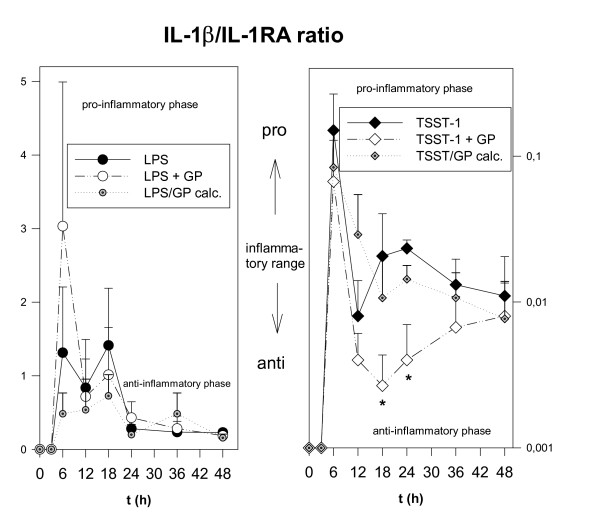
Decreased IL-1β/IL-1RA ratio following GP + TSST-1 when compared to TSST-1. Time course (48 h) of the IL-1β/IL-1RA ratio following incubation of human PBMC with LPS, TSST-1, GP + LPS, GP/LPS calc., GP + TSST-1 or GP/TSST-1 calc. LPS and GP + LPS treatments resulted in generating more IL-1β than IL-1RA up to 24 h. When comparing LPS or GP/LPS calc. vs GP + LPS we did not find significant alterations in the IL-1β/IL-1RA ratio over 48 h. With respect to TSST-1 or GP/TSST-1 calc. vs GP + TSST-1 we observed a pronounced anti-inflammatory action of GP, as demonstrated by an about 10–100 fold reduced ratio at 18 h and 24 h, i.e. a higher production of IL-1RA than of IL-1β (* = p < 0.05). Data are shown as mean ± SEM (n = 3).